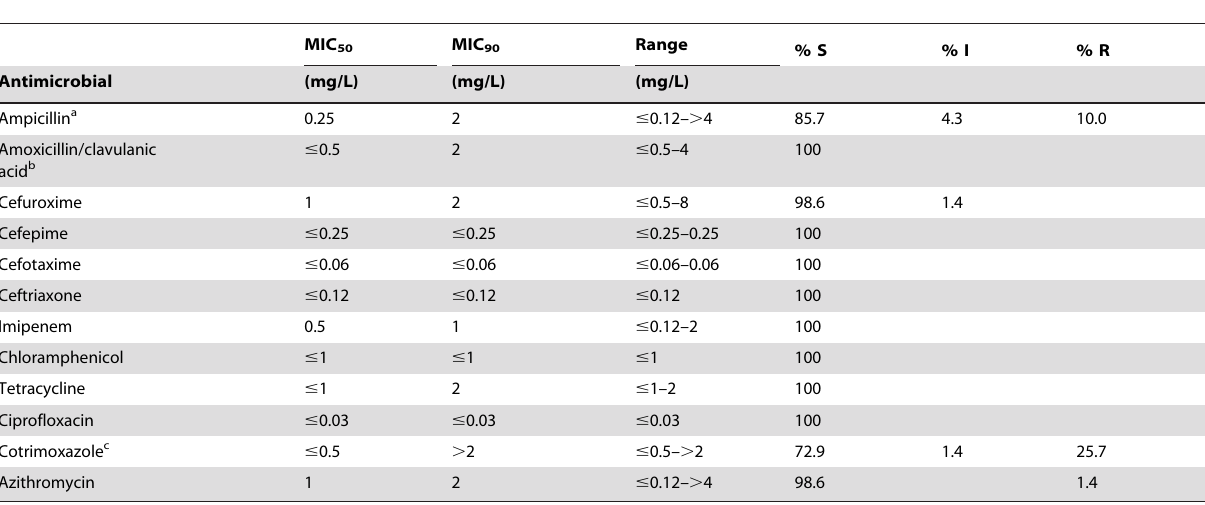
Table 2. Antimicrobial susceptibility of 70 invasive H. influenzae